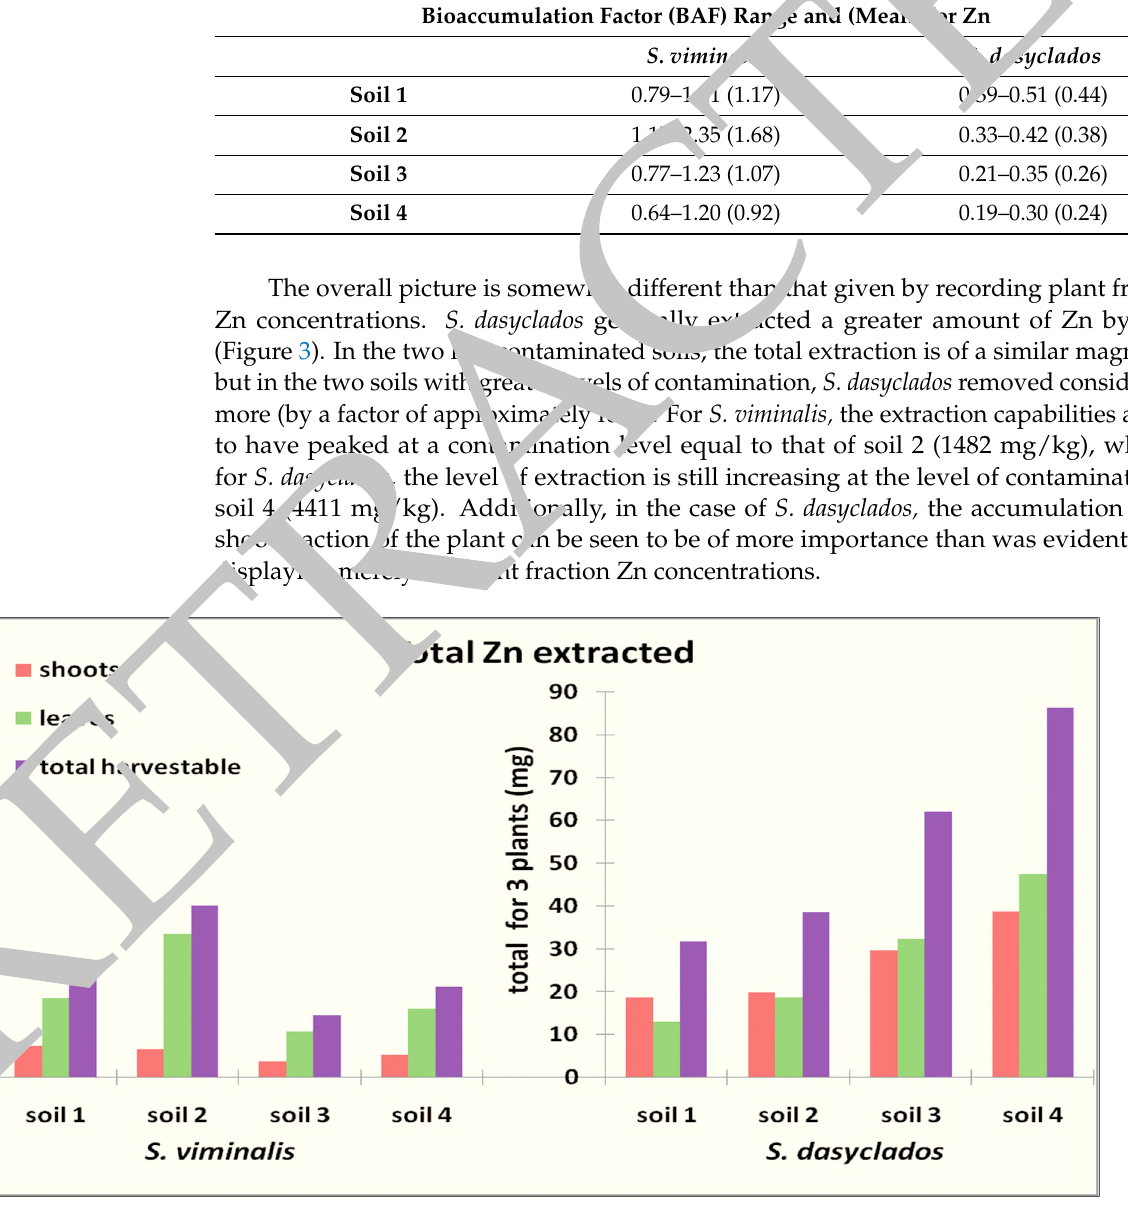
Figure 3. Total amounts by mass of Zn extracted by harvestable plant fractions with total values shown for each set of three plants of each species grown in each soil.